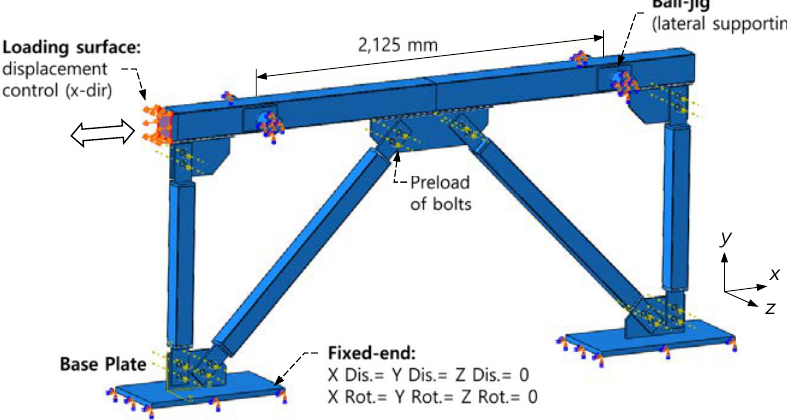
Figure 10. Analysis model, support constraints, and load conditions of S15-150.